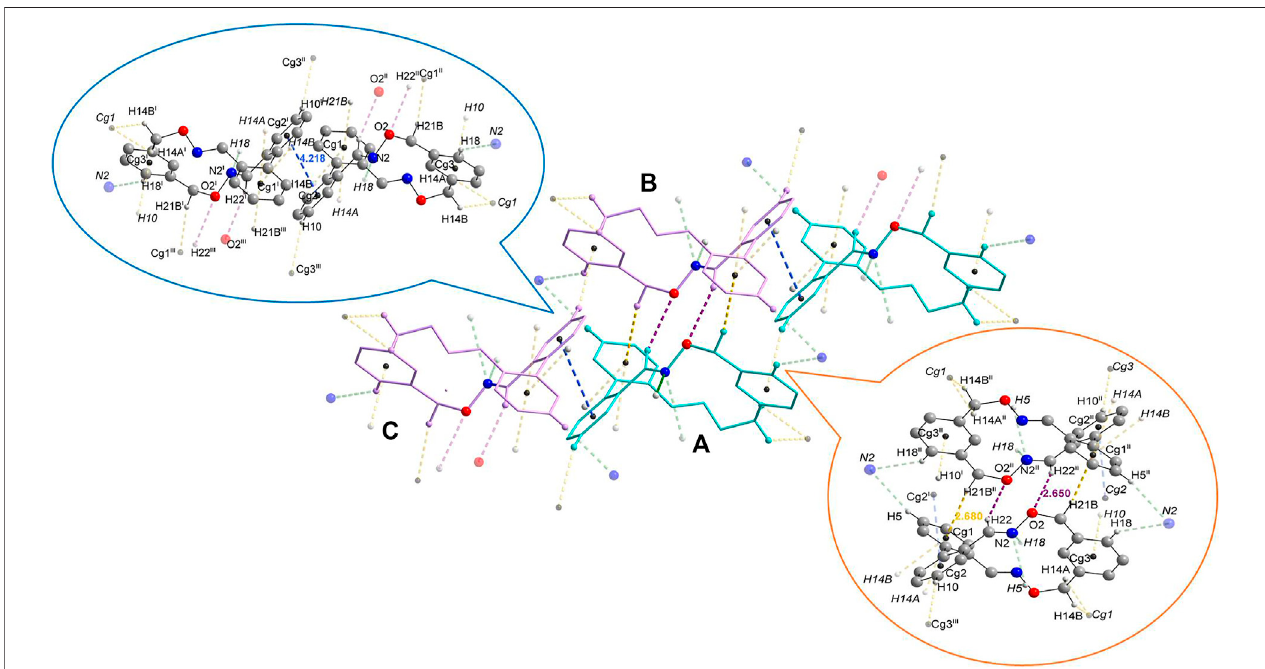
FIGURE 4 | Middle: Capped stick representation of a fragment of the lattice presenting the identi fi ed intermolecular contacts. The two enantiomers were represented in different colors for clarity (aqua for the P enantiomer and pink for the M enantiomer). Left inset: Ball and stick representation of a fragment of the lattice displayingthe A-B dimer formed byC – H ··· centroidand C – H ··· Ocontacts. Right inset: Ball andstick representation ofafragment ofthelattice displaying the A-C dimer formed by π ··· π interactions. For clarity, in all representations the main contacts are drawn in full colors while the rest of the interactions are shown in more transparent colors(violet for C – H ··· O, blue for centroid ··· centroid,green for C – H ··· N, yellow for C – H ··· centroid contacts), the atoms involved in intermolecular interactions were highlighted/labelled and H atoms not involved in contacts were omitted.